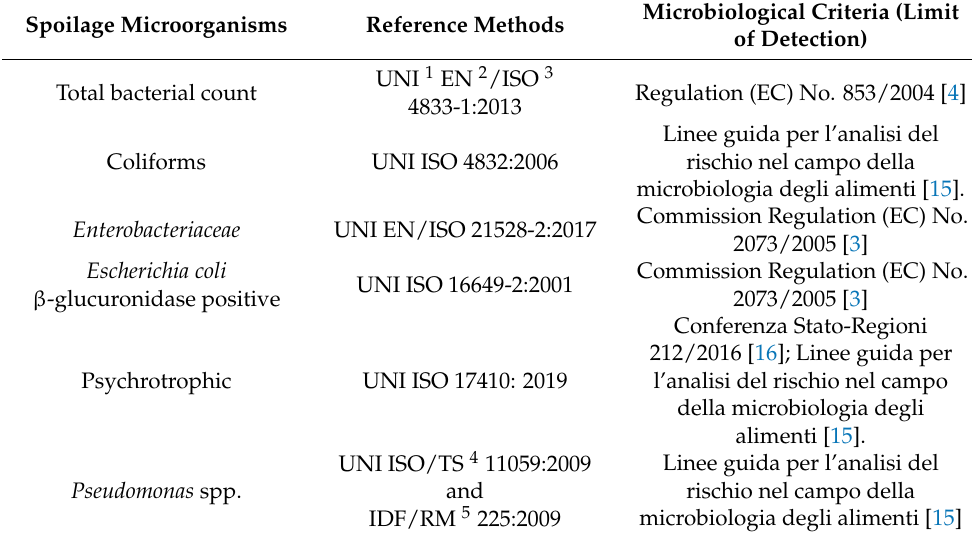
Table 1. Reference methods and limit of detection for the microbiological analyses of spoilage, pro-technological and pathogenic